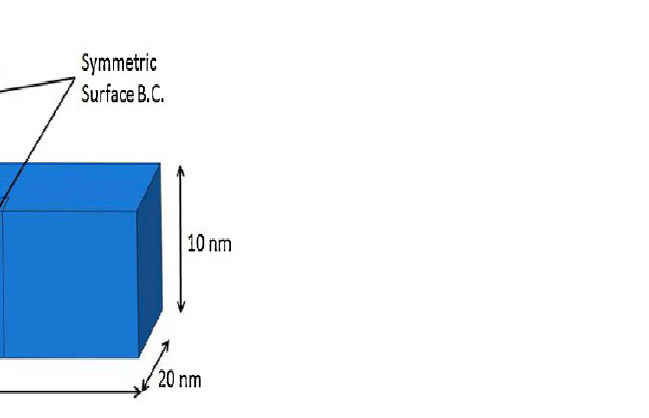
Figure 49. The spherical diamond abrasive, the silicon workpiece, and the boundary conditions for the symmetric surface [247].